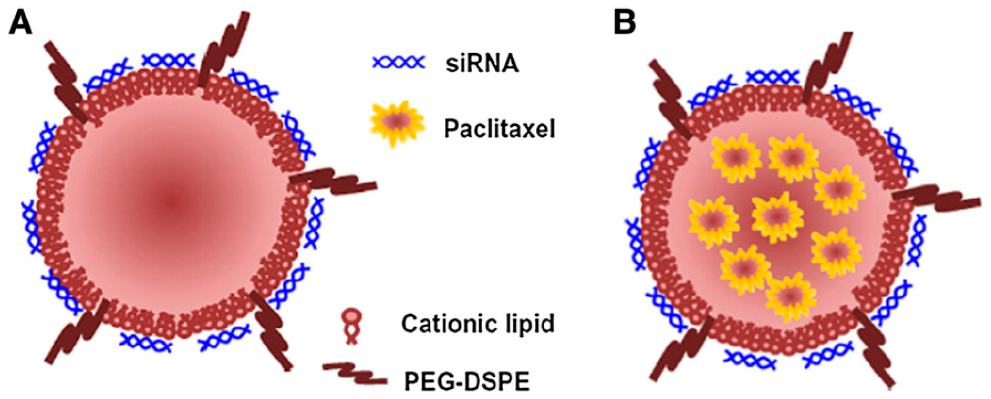
Figure 5. Multimolecular structures have a hydrophobized core (Taken with permission from [52]. Copyright Elsevier, 2014).